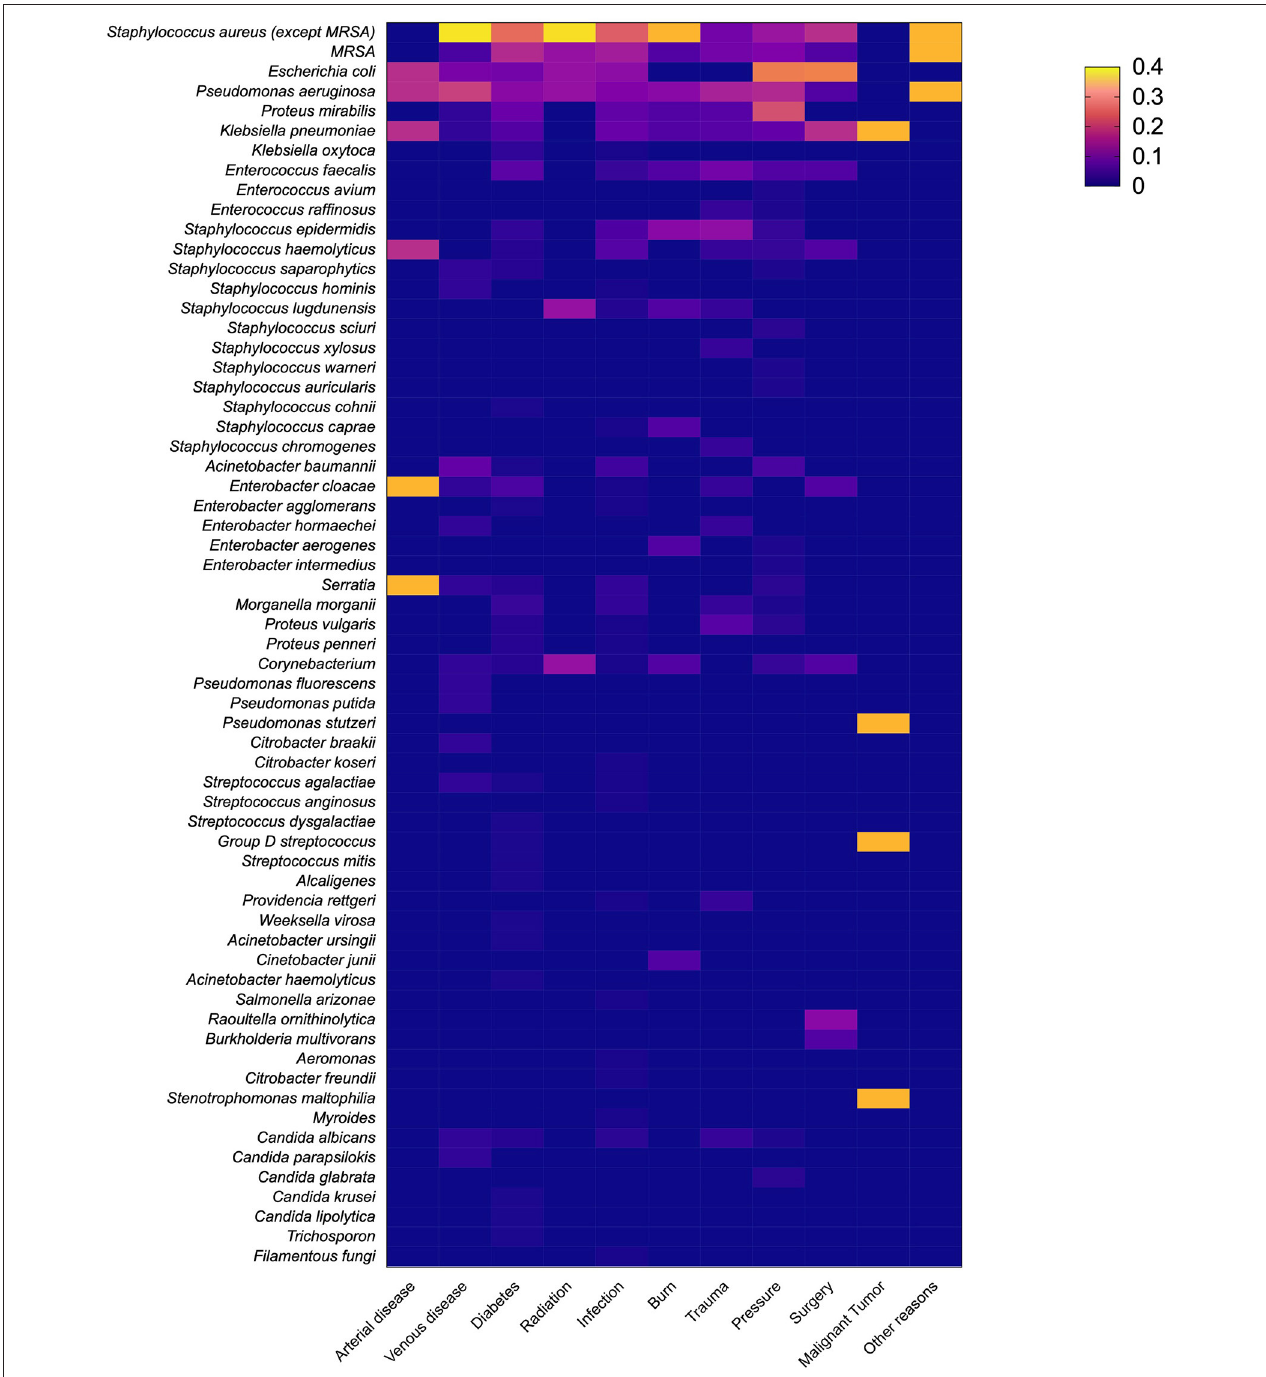
FIGURE 4 | The distribution of pathogens in wounds of different causes. Different colors indicate the percentage of each pathogen in wounds of different etiologies.